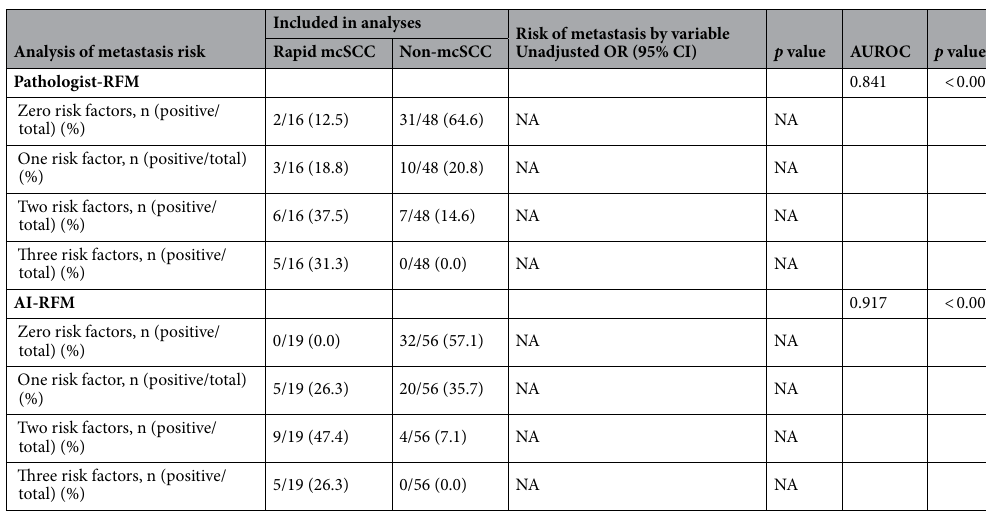
Table 2. Analysis of metastasis risk utilizing final rapid metastasis -AI-model cohorts. *Alternative grouping in which 20–29.9 mm and ≥ 30 mm categories are combined. AI: artificial intelligence; AI (met): analyzed by AI as metastatic; AJCC-8: The eight edition of American joint committee on cancer tumor staging; AUROC: area under receiver operating characteristic curve; BWH: Brigham and Women’s Hospital tumor staging; CI: confidence interval; Clark (5): Clark’s level 5; Diameter (≥ 30): tumor diameter ≥ 30 mm; mcSCC: primary metastatic squamous cell carcinoma; OR: odds ratio; Pathologist (met): analyzed by pathologist as metastatic; positive/total: tumors with named category out of all tumors with known information about named feature; RFM: risk factor model; ref: reference category.